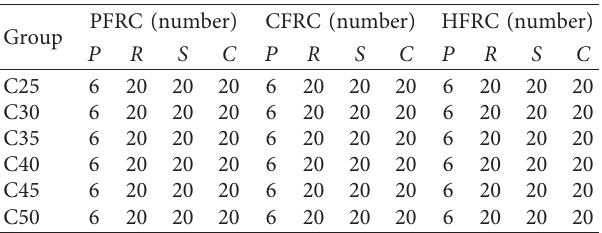
Table 3: Experimental scheme showing the number of specimens tested for each type of test and concrete strength